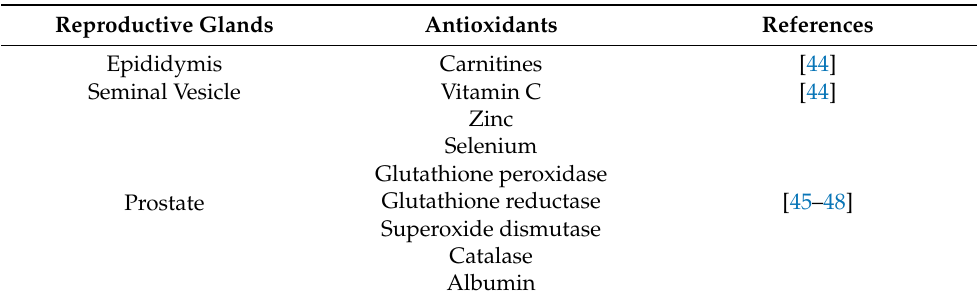
Table 1. Information available on the principal seminal plasma antioxidants and the main male reproductive glands responsible for its